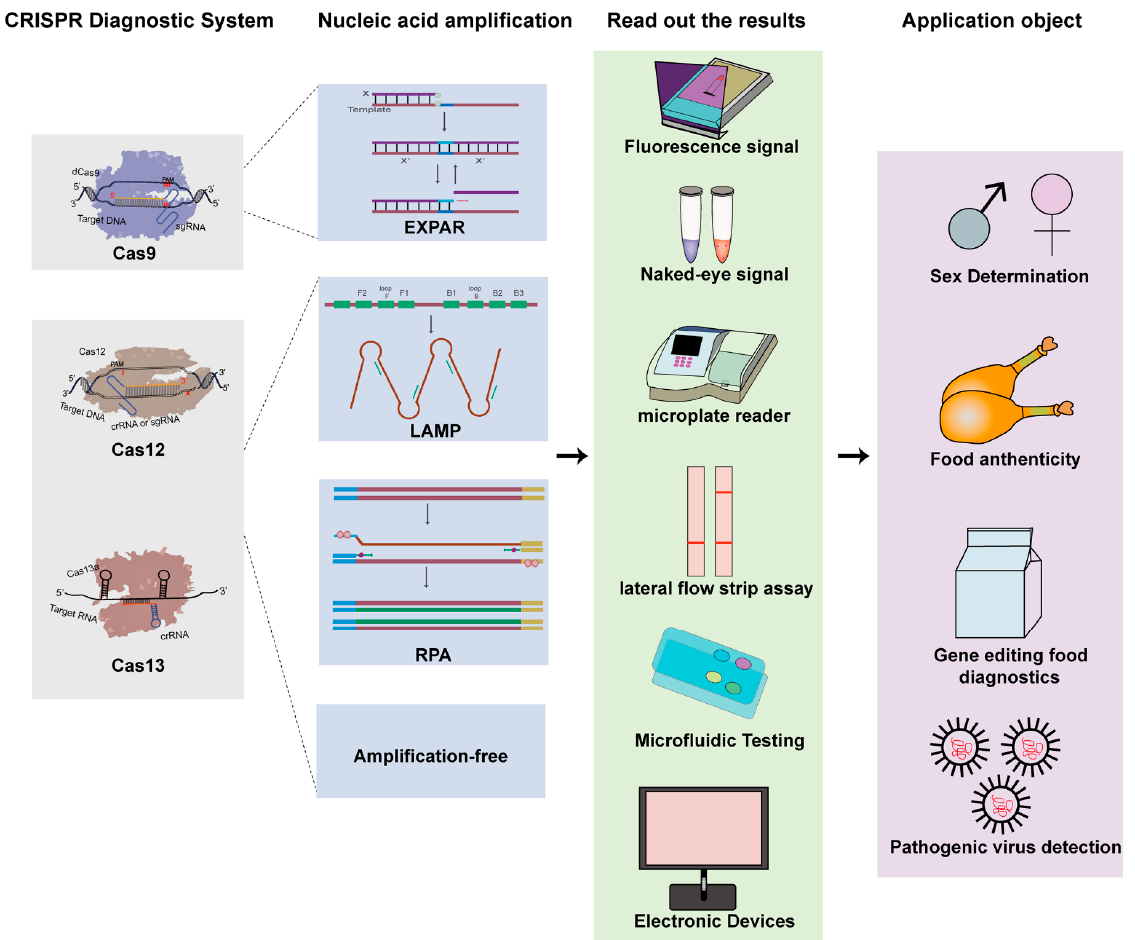
Figure 1. Schematic principle of clustered regularly interspaced short palindromic repeats (CRISPR) Class 2 systems in nucleic acid detection and the applications of CRISPR and the associated protein systems (CRISPR/Cas)-based diagnostics in livestock industry.